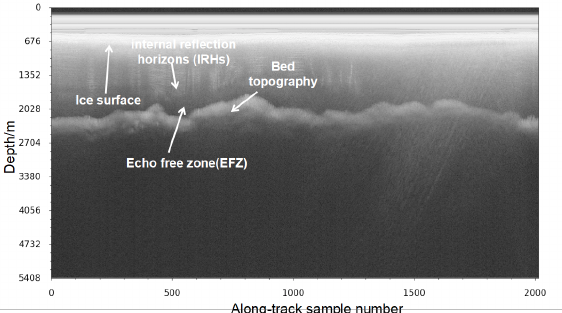
Figure 1. Ice sounding radar echogram obtained after on-site data processing, from CHA2/GCX0e/F09T06a